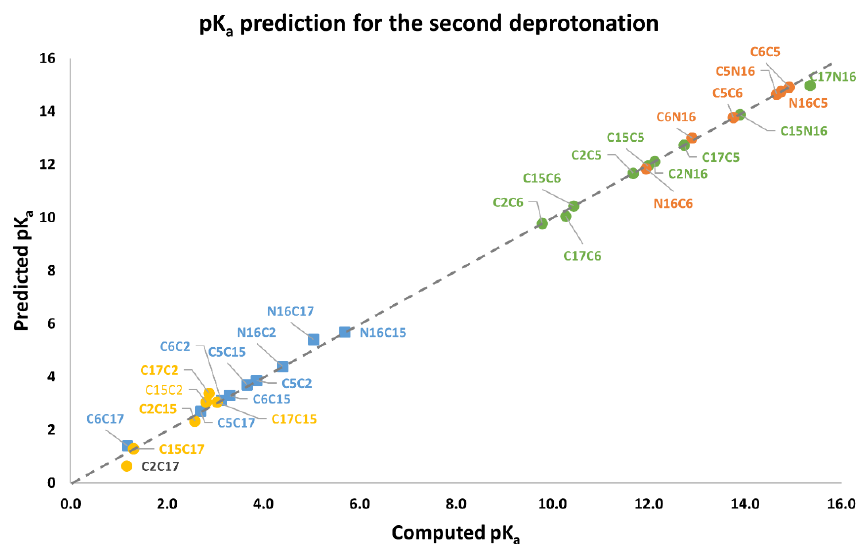
Figure 15. pK a calculation using a direct approach for the first round of deprotonation. Two subclusters are formed: I 1 , with C2, C15, and C17; S 1 , with C5, C6, and N16.